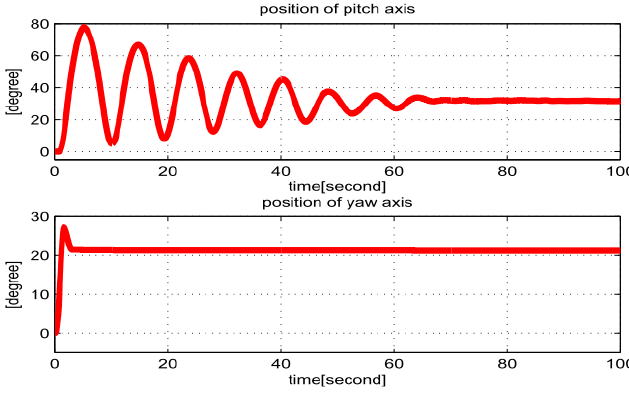
Fig. 6. Angular pitch (top) and yaw (bottom) positions for lag compensators of the form